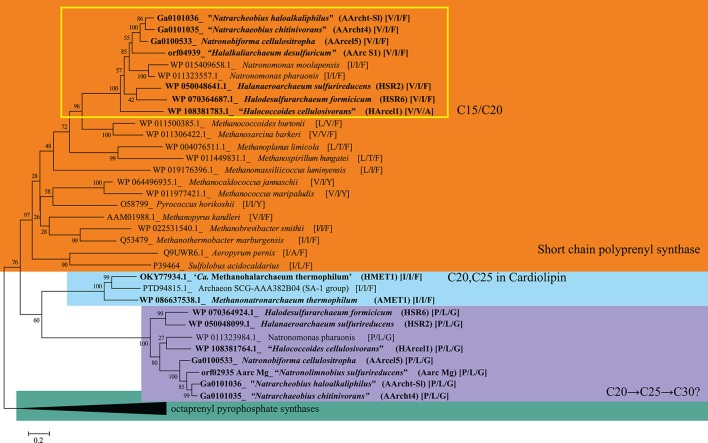
Phylogenetic tree of putative polyprenyl synthases involved in isoprenoid elongation. Phylogenetic reconstruction was performed by maximum likelihood as indicated in the methods. The percentage of replicate trees in which the associated taxa clustered together in the bootstrap test (1,000 replicates) are shown next to the branches. The tree is drawn to scale, with branch lengths in the same units as those of the evolutionary distances used to infer the phylogenetic tree. The nature of the amino acids at the 11th, 8th, and 5th position before the aspartate-rich motif is given in square brackets e.g., (AA11, AA8, AA5). Full strain names given in Table 1. Amino acid codes: V, valine; I, isoleucine; F, phenylalanine; A, alanine; L, leucine; T, threonine; Y, tyrosine; P, proline; G, glycine.